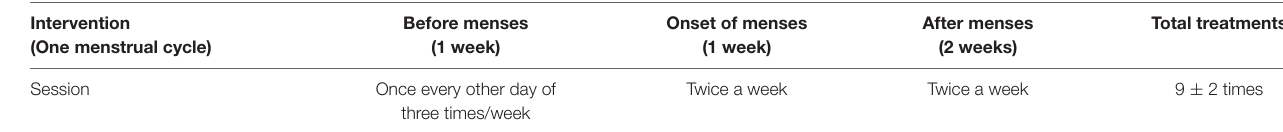
TABLE 2 | Intervention sessions of the two groups. Intervention (One menstrual cycle)